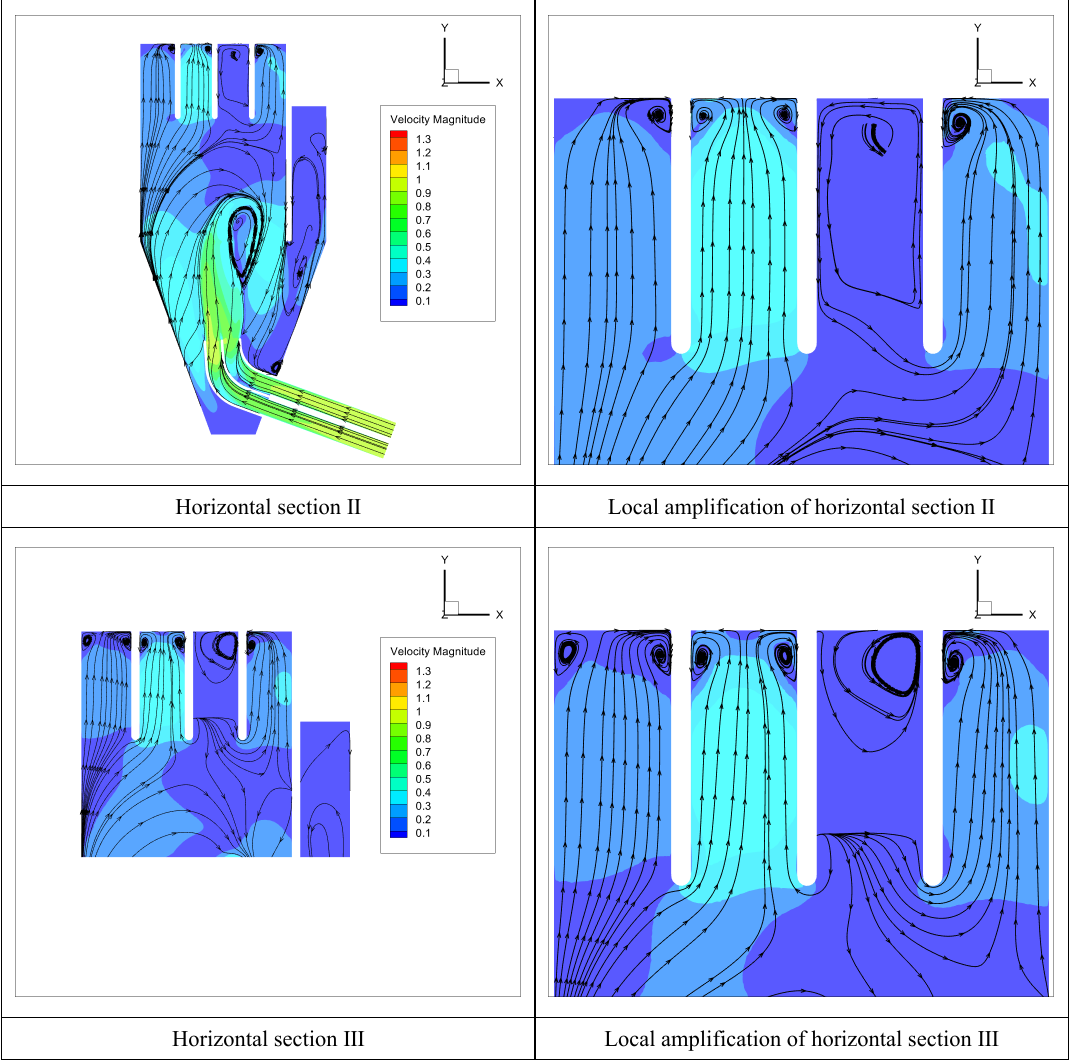
Figure 10. Flow pattern for the optimal scheme of the diversion piers for operating pumps 1, 3, and 4.